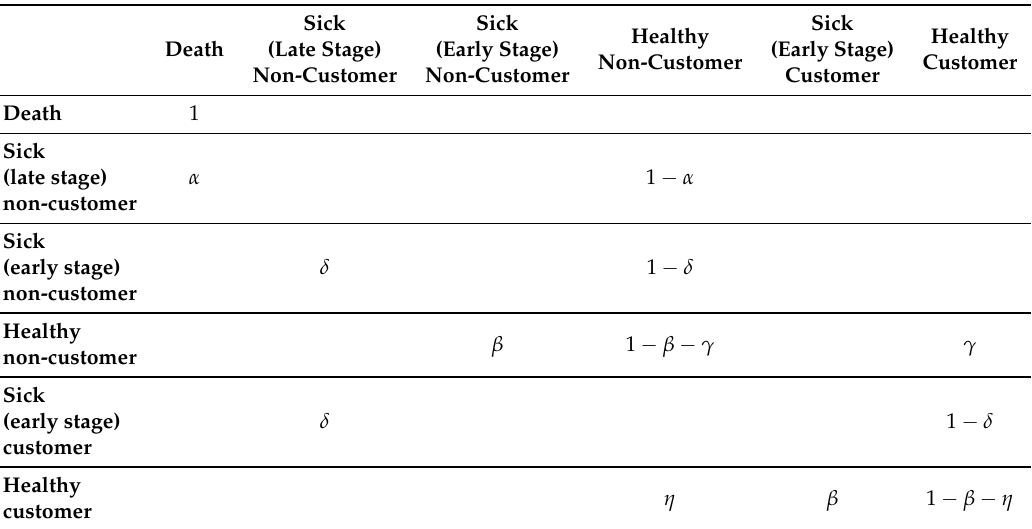
Figure 1. States in pandemic outbreak. Table 2. Transition probabilities among the